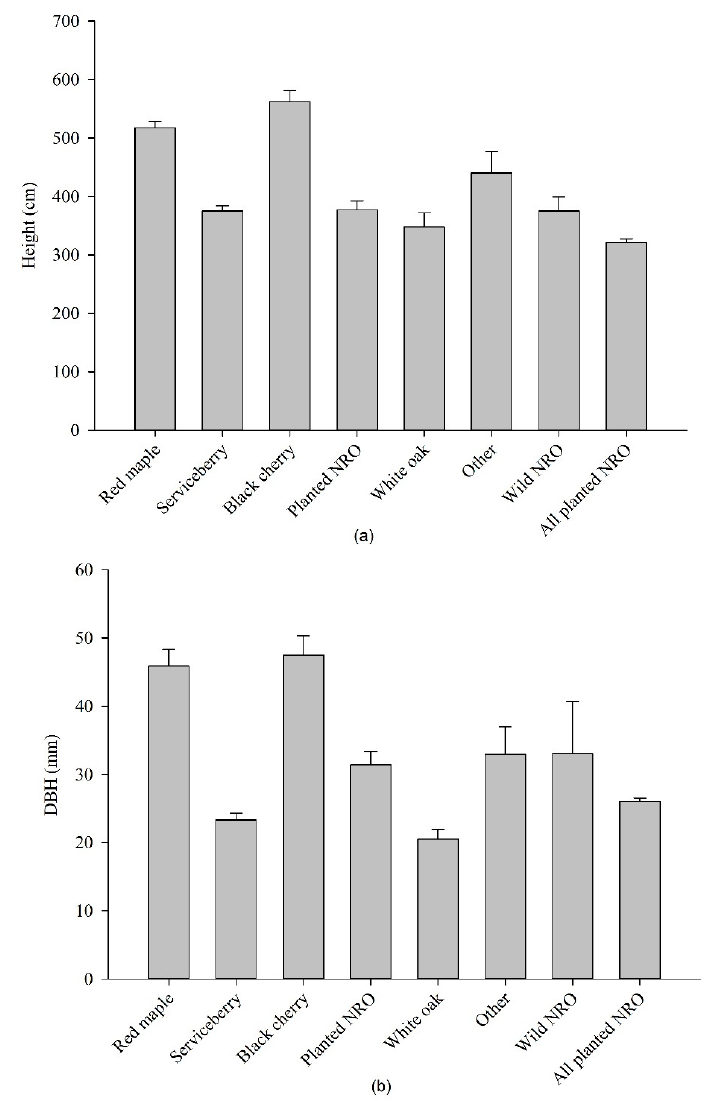
Figure 5. ( a ) Mean height of tallest woody stem found in competition plots, by species and mean height of the planted northern red oak trees. “Planted NRO” includes only planted northern red oak trees found in competition plots, while “All planted NRO” includes all planted northern red oak; ( b ) Mean DBH of tallest woody stem found in competition plots, by species and mean DBH of all planted northern red oak.